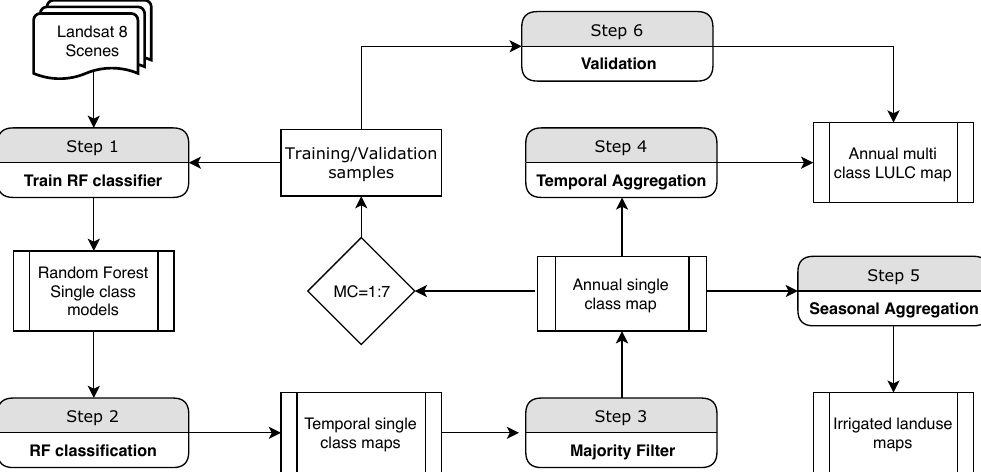
Figure 6. Block diagram showing the key steps of the methodology used in this study. For each Major Class (MC), Steps 1–3 were repeated to develop single class maps, followed by temporal